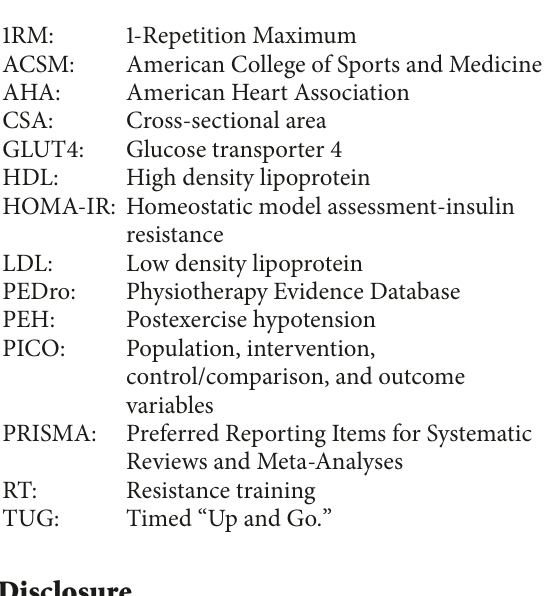
duration of training, and weekly frequency) in the search for benefits for individuals with